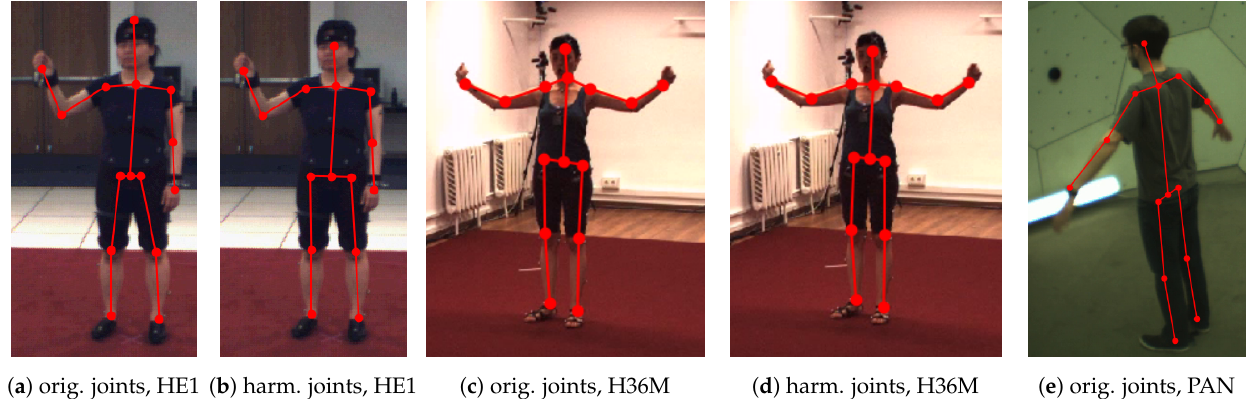
Figure 2. Examples showing the skeleton of HumanEva-I (HE1) and Human3.6M (H36M) before (“original” = orig.) and after the harmonization (harm.) of the head, neck, and hip joints. Panoptic (PAN) was used as the reference for